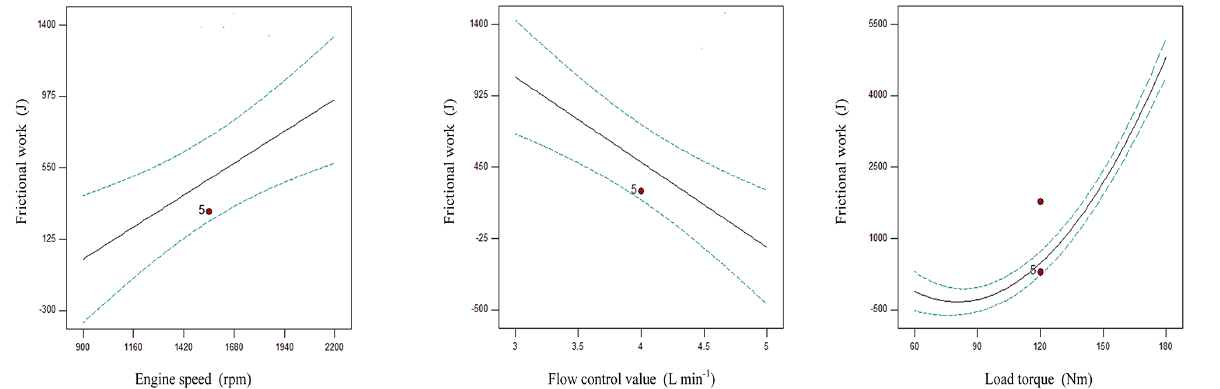
Figure 8. Single influencing factor analysis of frictional